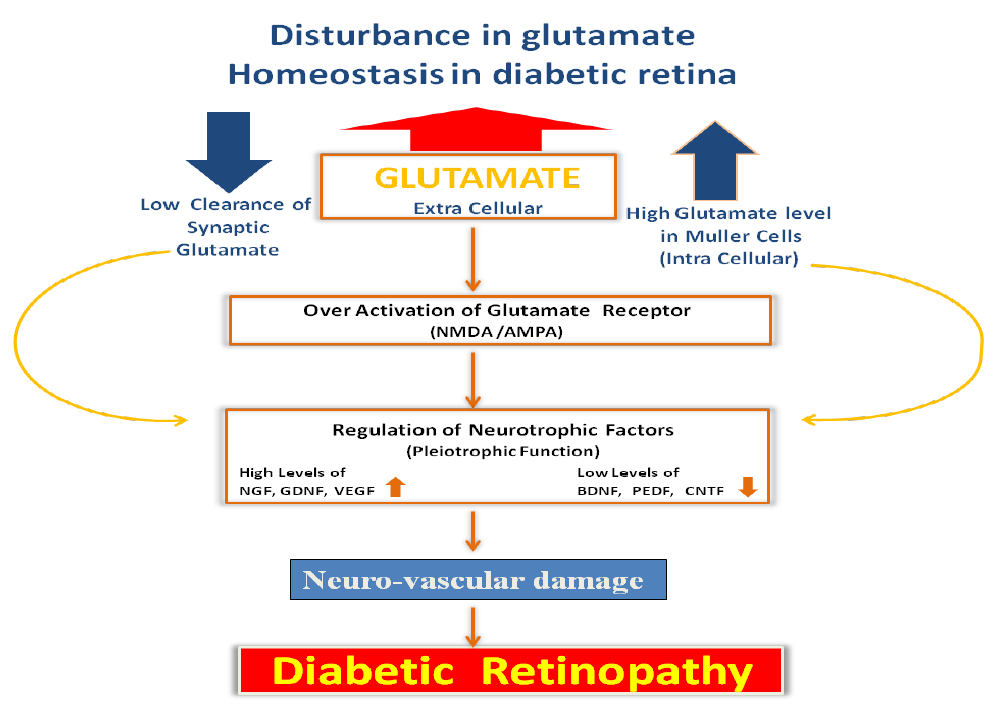
Scheme 1. Flow diagram depicting the effect of dysregulated level of glutamate within diabetic retina. Dysregulated levels of glutamate within neurons and glial cells, as well as increased levels in the extracellular space within the retina, can cause excitotoxicity